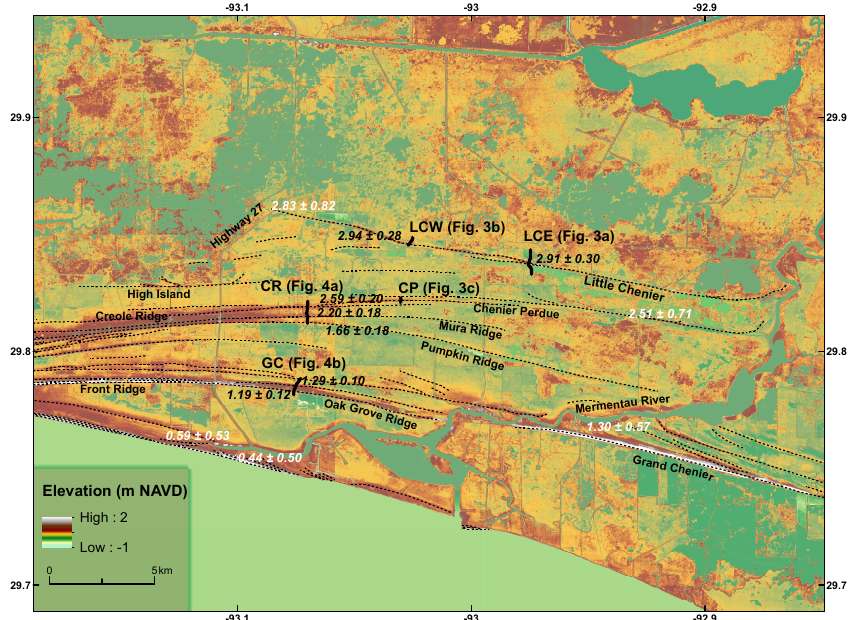
Figure 2. Digital elevation map (NED 1/3arcsec) of the Chenier Plain study area (for location see Fig. 1a) with the location of the different cross sections: Little Chenier East (LCE), Little Chenier West (LCW), Chenier Perdue (CP), Creole Ridge (CR, consisting of Chenier Perdue, Mura Ridge and Pumpkin Ridge) and Grand Chenier/Oak Grove Ridge (GC). The OSL ages (Table 1) are shown in black, selected radiocarbon ages from Gould and McFarlan (1959) are in white (Table S1). The OSL ages and the calibrated radiocarbon ages are expressed in ka ( ± 2 σ ) with respect to AD 2010. The dotted lines indicate the position of